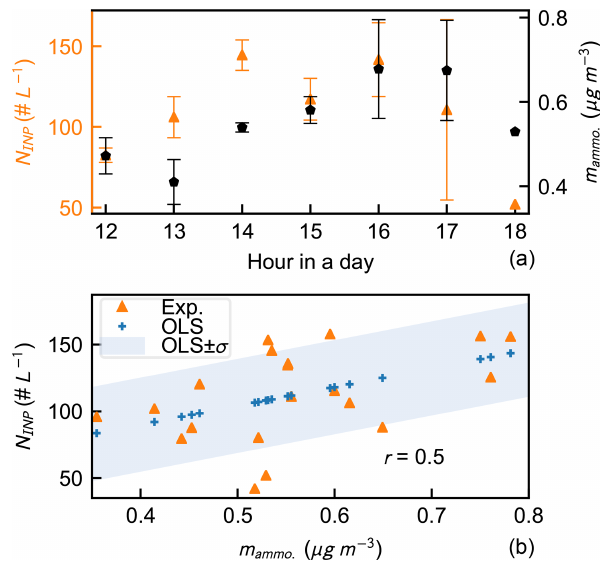
Figure 7. Diurnal profile of (a) and correlation between (b) N INP and m ammo . during the dust event. The blue markers in panel (b) in- dicate the predicted N INP using fitted linear regression parameters. The blue shading indicates ± 1 σ of measured N INP from predicted N INP